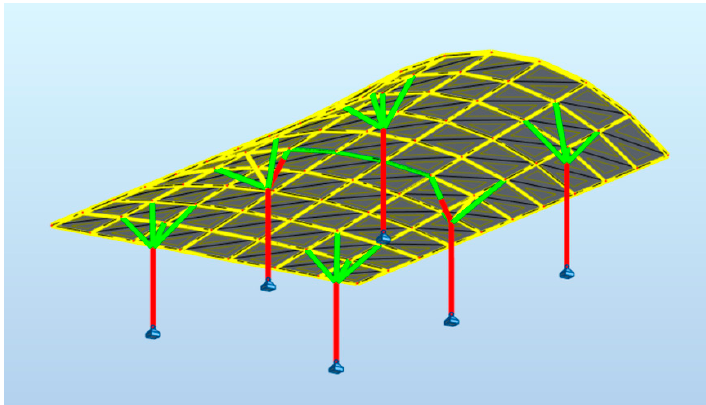
Figure 9. Maps on bars—distribution of axial force F X.